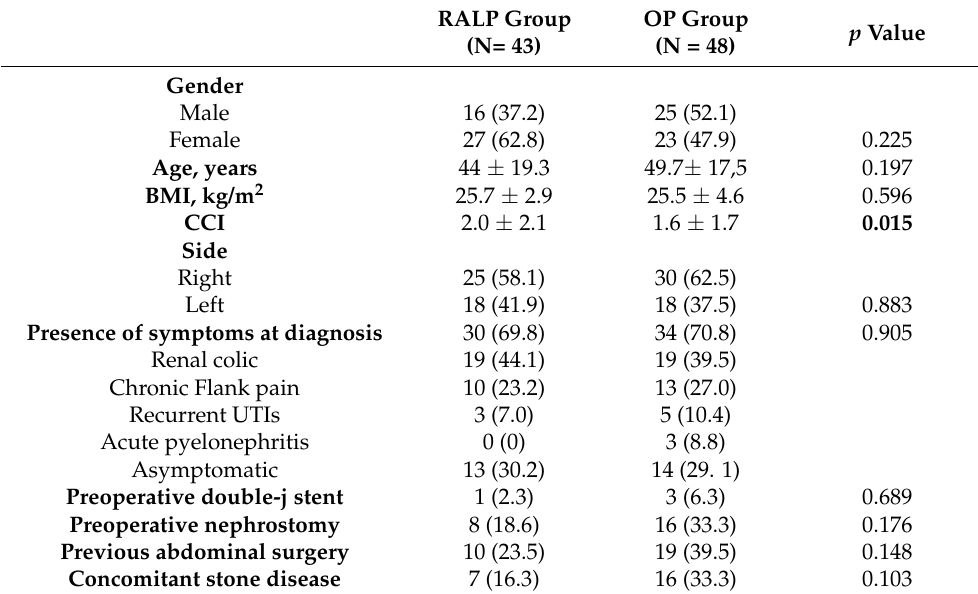
Table 1. Main demographic and preoperative data in the patients from the two groups. Values are means ± standard deviation or numbers with percentages.